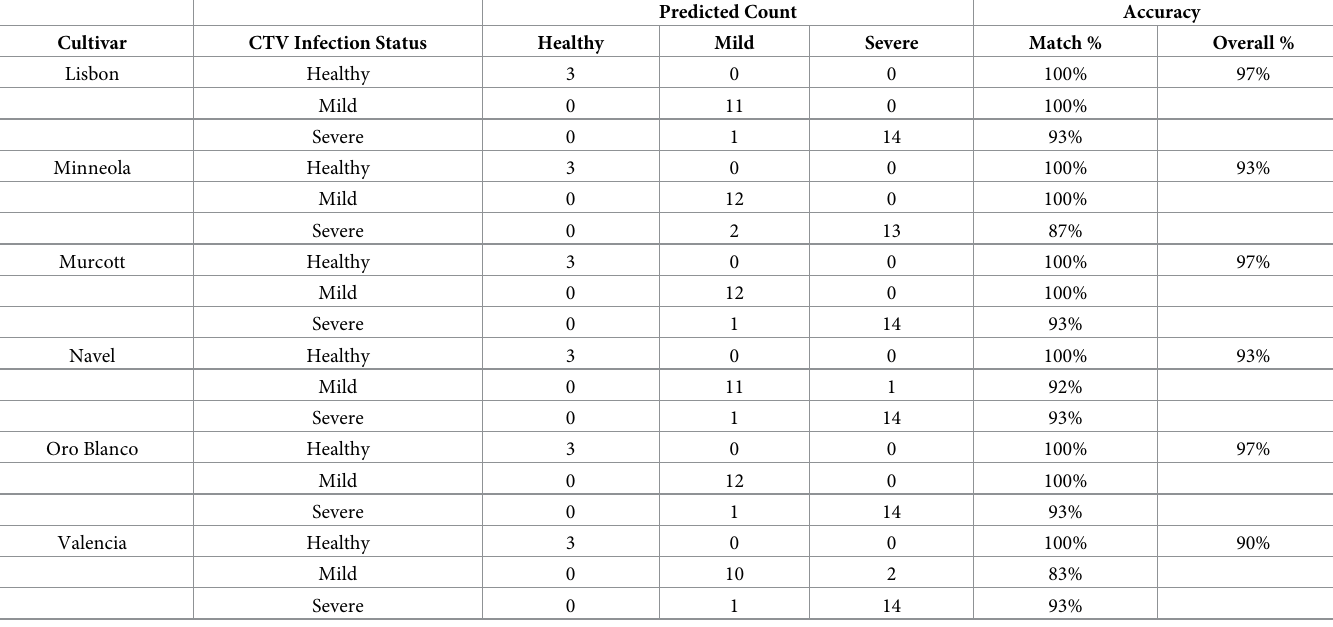
Table 5. CDA utilizing amino